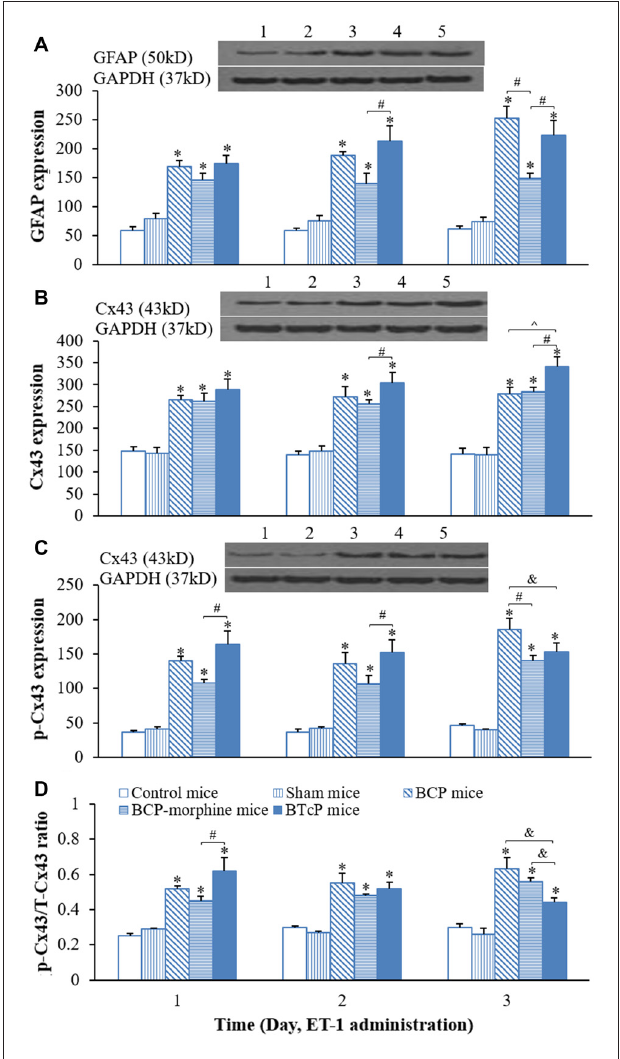
FIGURE 2 | Protein expressions of glial fibrillary acidic protein (GFAP) (A) Cx43 (B) p-Cx43 (C) and the ratio of p-CX43/T-Cx43 (D) in normal, sham, BCP, BCP-morphine and BTcP mice. The bands of Western blotting in (A–C) : (1) protein extracts from the tissues of spinal cord in a representative control mice; (2) protein extracts from the tissues of spinal cord in a representative sham mice; (3) protein extracts from the tissues of spinal cord in a representative BCP mice; and (4) protein extracts from the tissues of spinal cord in a representative BCP-morphine mice; and (5) protein extracts from the tissues of spinal cord in a representative BTcP mice. Five mice were used for each group. GFAP, Cx43 and p-Cx43 were analyzed by Western blotting and the ratio of p-CX43/T-Cx43 was calculated from phosphonated Cx43 and total Cx43. ∗ P < 0.05, vs. control or sham mice; # P < 0.05, vs. BCP-morphine mice; ∧ P < 0.05, vs. BCP mice; & P < 0.05, vs. BTcP mice.